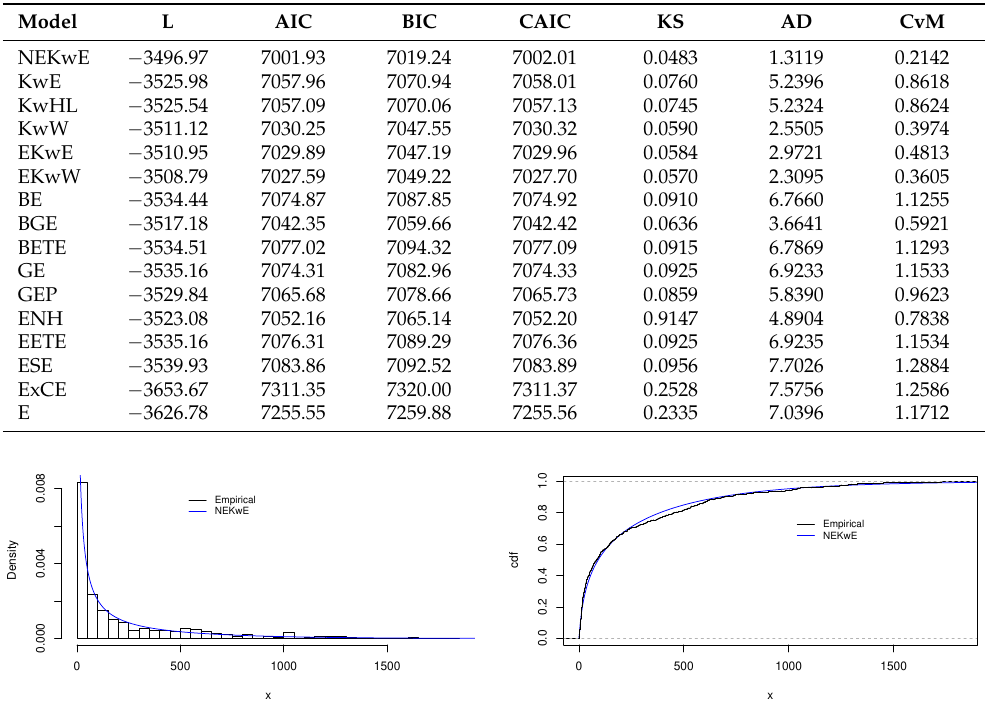
Figure 6. Plots of the histogram with ( left ) the fitted pdf and ( right ) fitted cdf of the NEKwE model for the second data set.